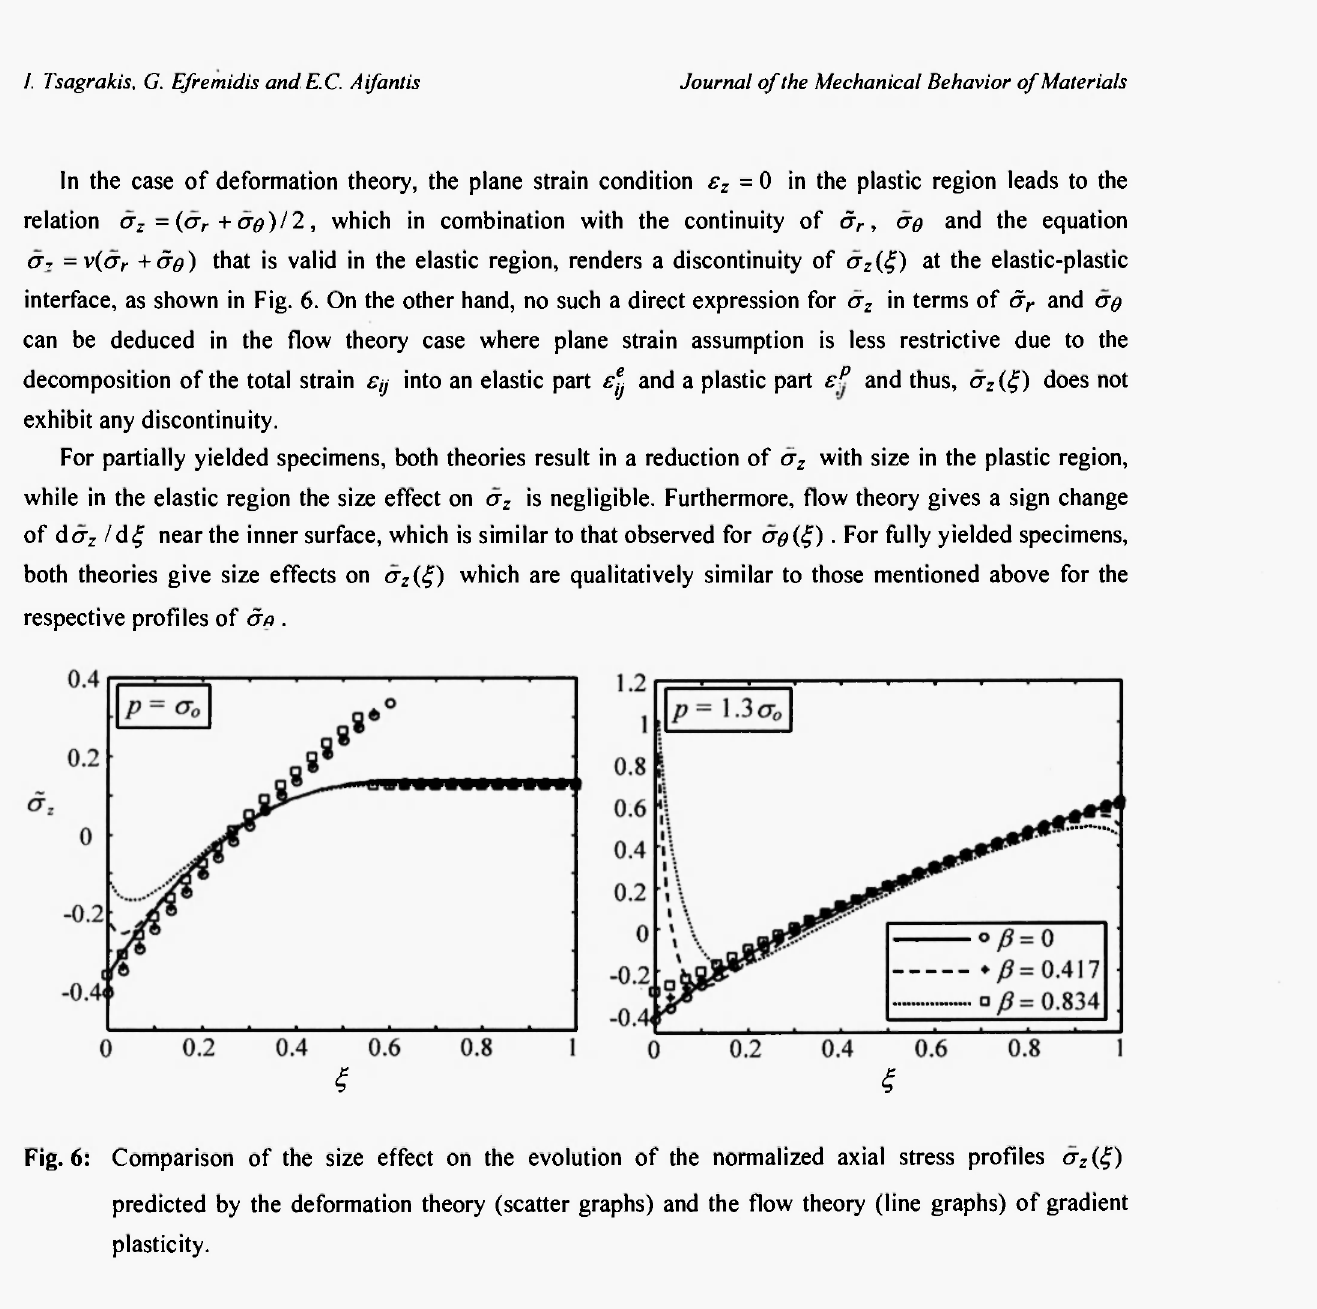
Fig. 6: Comparison of the size effect on the evolution of the normalized axial stress profiles σ ζ (ξ) predicted by the deformation theory (scatter graphs) and the flow theory (line graphs) of gradient